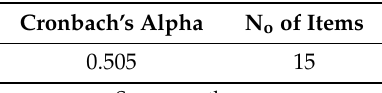
Table 4. Reliability